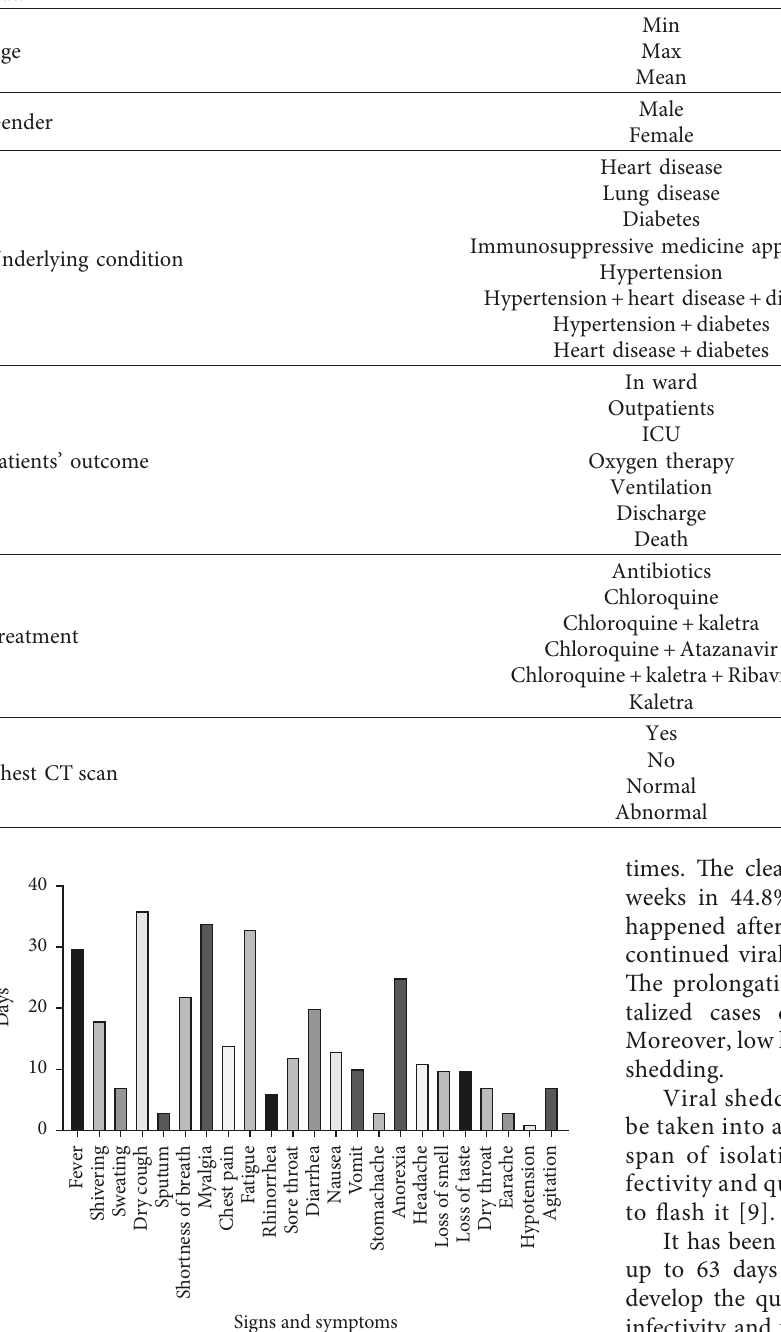
Table 1: Demographic, underlying condition, treatment, chest CT scan findings, and outcomes of COVID-19 patients ( n